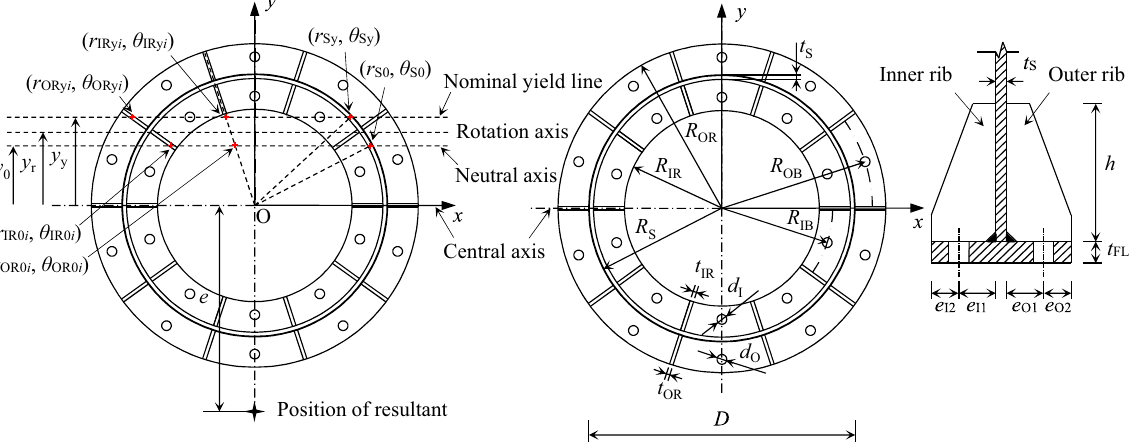
Figure 2. Configuration and geometric parameters of inner-outer flange connection.